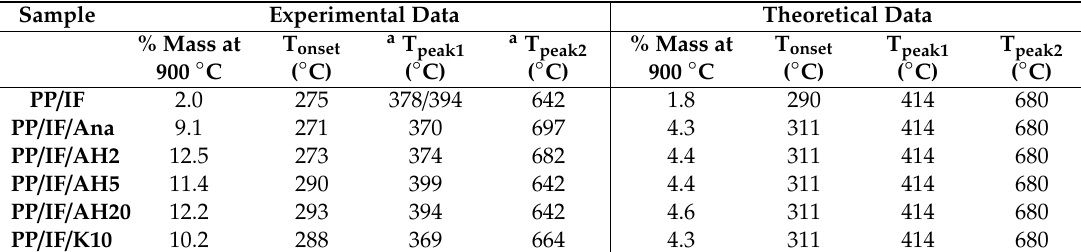
Table 5. Experimental and theoretical data for TGA and dTG curves for the PP / FI and PP / FI / clay mineral systems. Sample Experimental